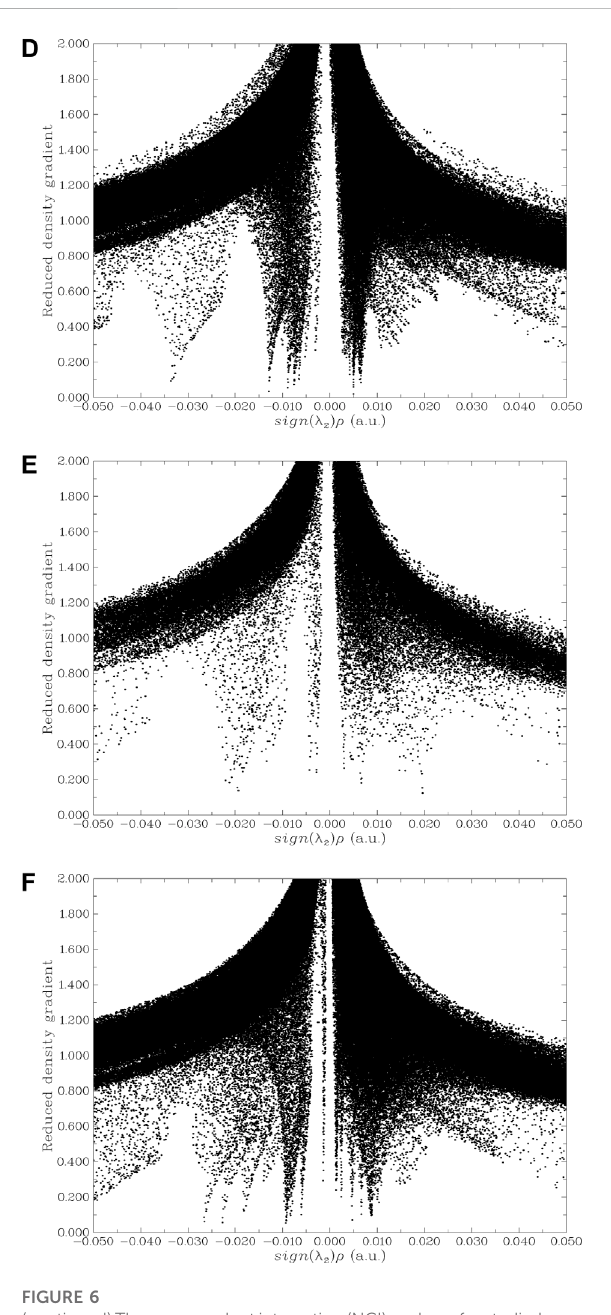
(continued)Thenon-covalentinteraction(NCI)analysesforstudied AAILs and AAIL ... SO 2 complexes. (A) [C 3 MIM][GLY] AAIL, (B) [C 3 MIM] [GLY] ... SO 2 , (C) [C 3 COOHMIM][GLY], (D) [C 3 COOHMIM][GLY] ... SO 2 ,